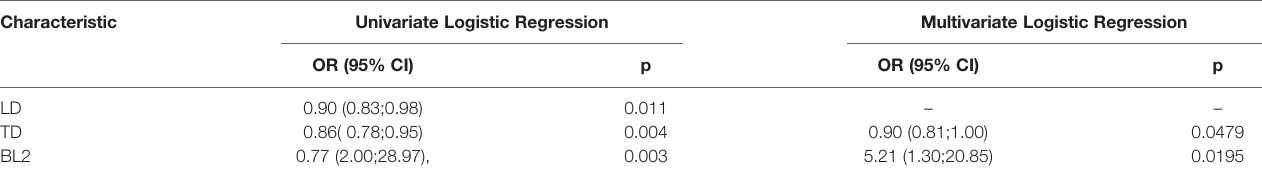
TABLE 2 | Clinically signi fi cant factors and independent predictors. Characteristic Univariate Logistic Regression